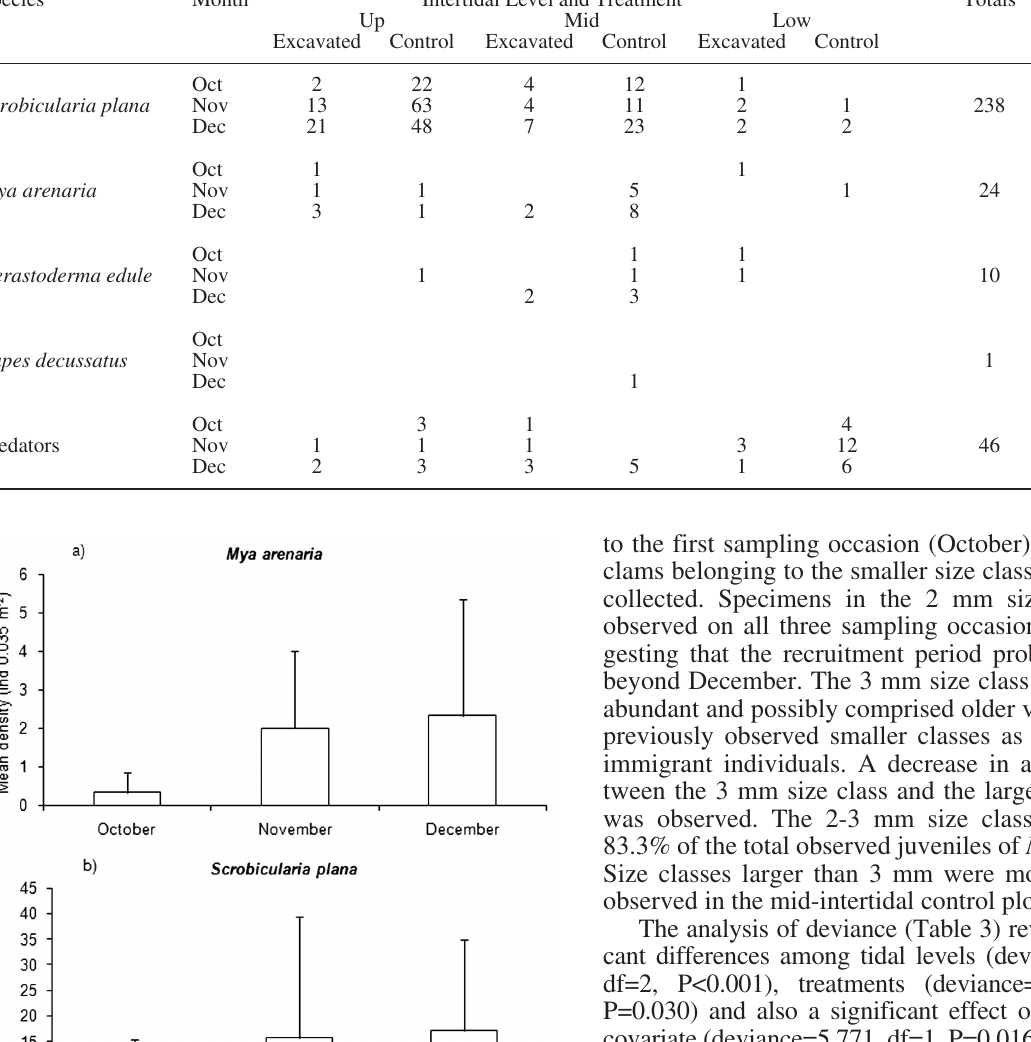
Table 2. – Total and relative number of juvenile bivalves and total number of predators observed in the experimental plots over time. Species